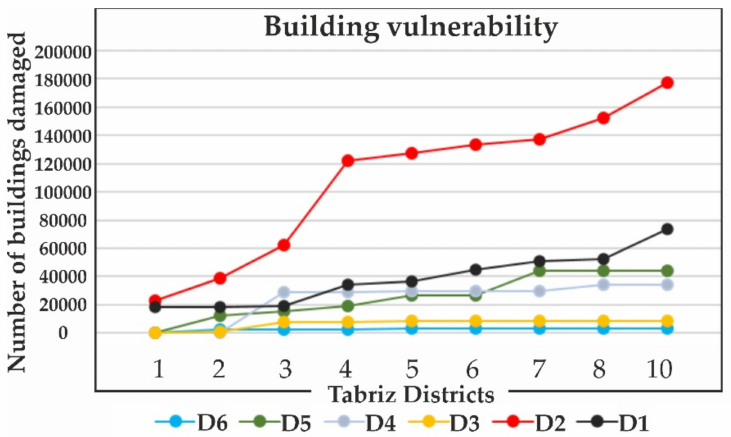
Figure 24. Graph showing the level of destruction of some of the buildings for the earthquake that took place in